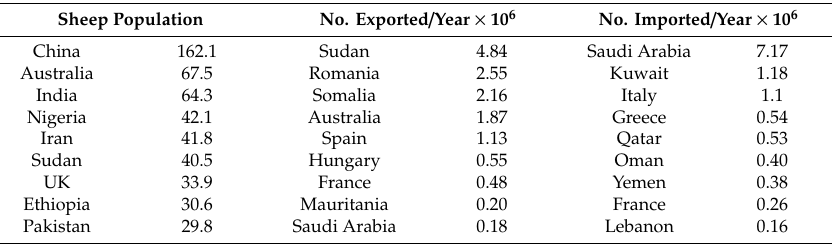
Table 1. The world’s countries in rank order of sheep population, and numbers of animals exported and imported ( × 10 6 )